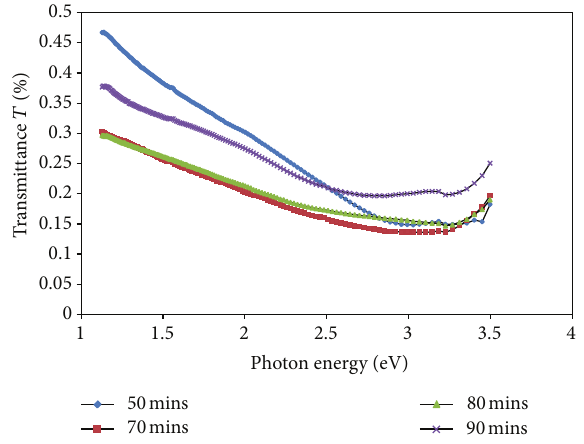
Figure 6: Transmittance versus photon energy.